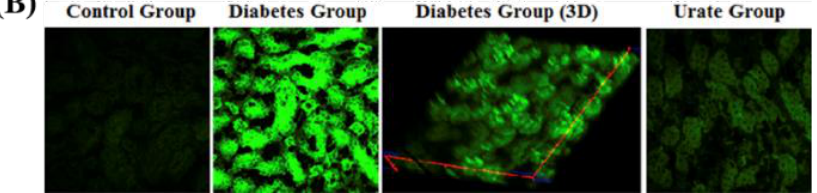
Figure 13. ( A ) Imaging mechanism of probe 15 − 17 ; ( B ) the representative fluorescence images of kidney slices of rats in different groups (i.e., control group, diabetes group, and urate group), respectively. The red line in ( B ) represents the coordinate axis of 3D imaging. Conditions: λ ex = 488 nm, λ em = 500 − 600 nm. Adapted from Reference [91]. Copyright 2016, Elsevier B.V.